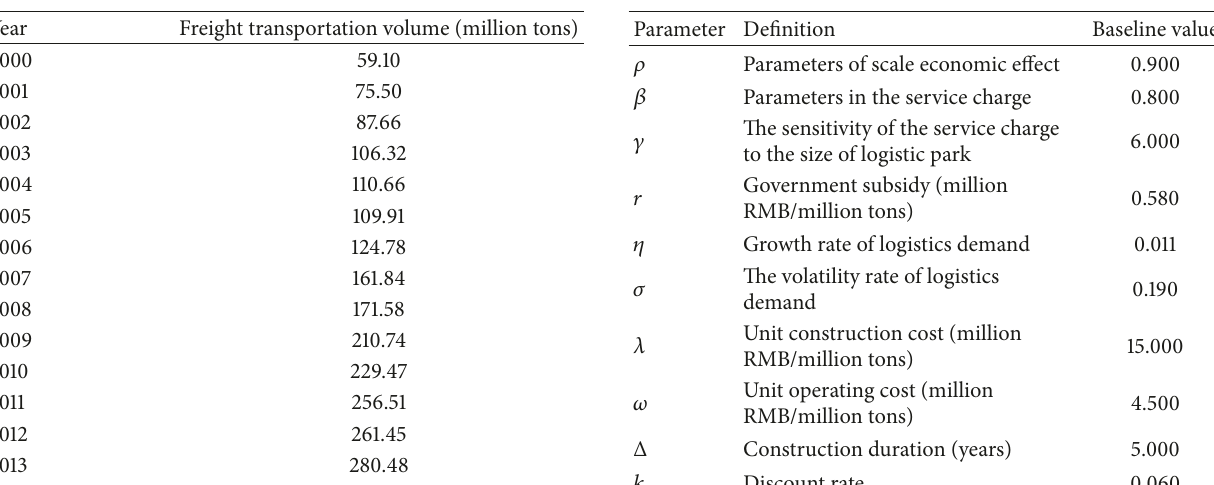
Table 1: Freight transportation volume of Changsha City. Table 2: Input parameters for model application.